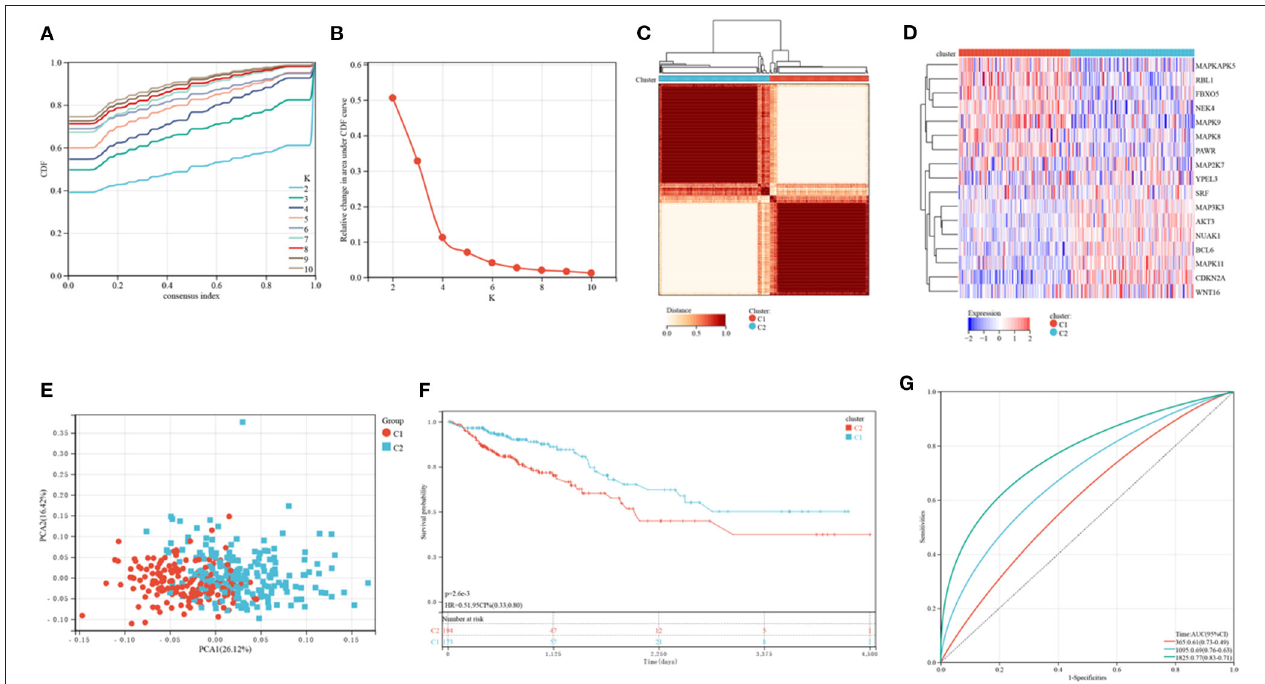
FIGURE 2 | Consensus clustering of CRC subtypes based on SRGs. (A) CDF plots of the consensus score ( k = 2–10). (B) Relative alterations in the regions under the CDF plot ( k = 2–10). (C) Consensus matrix heatmap identifying two clusters ( k = 2) and their related regions. (D) Expression of SRGs in the two distinctive subtypes. (E) PCA analyses showing marked differences in the transcriptomes of the two subtypes. (F) Kaplan-Meier analyses of OS of patients in the two subtypes. (G) ROC for predicting the specificity and sensitivity of 1, 3, and 5-year survival of patients in the two